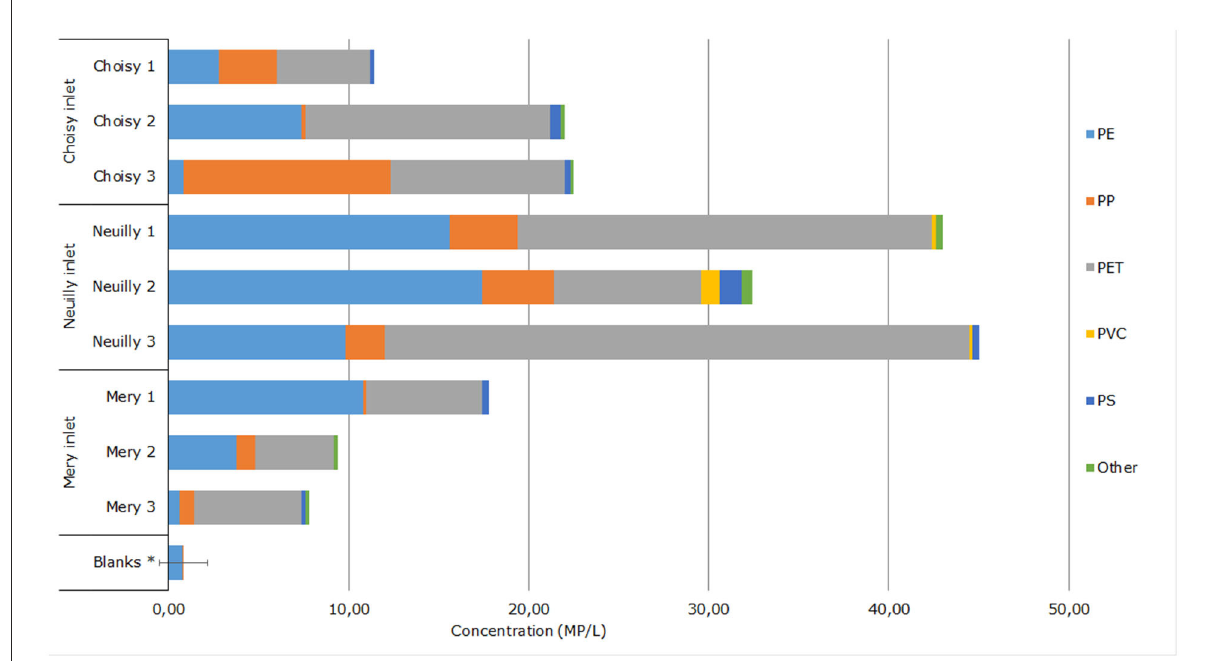
FIGURE2 Microplastic concentrations and polymer distributions in inlet water. * n = 4, mean ± standard